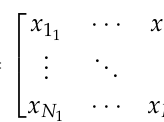
Figure 2. Aggregation method where profiles are aggregated hourly.